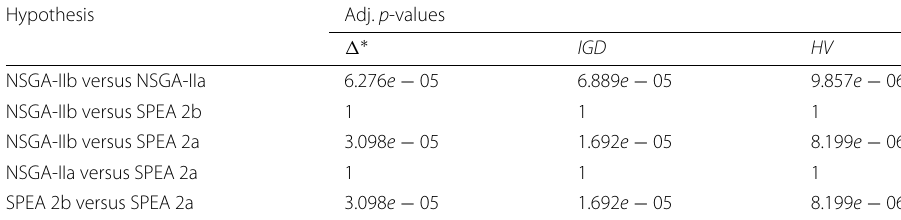
Table 11 Adjusted p -values for the Friedman aligned post-hoc test with Bergmann and Hommel’s correction for multiple comparisons among the four algorithms Hypothesis Adj. p -values (cid:6) ∗ HV NSGA-IIb versus